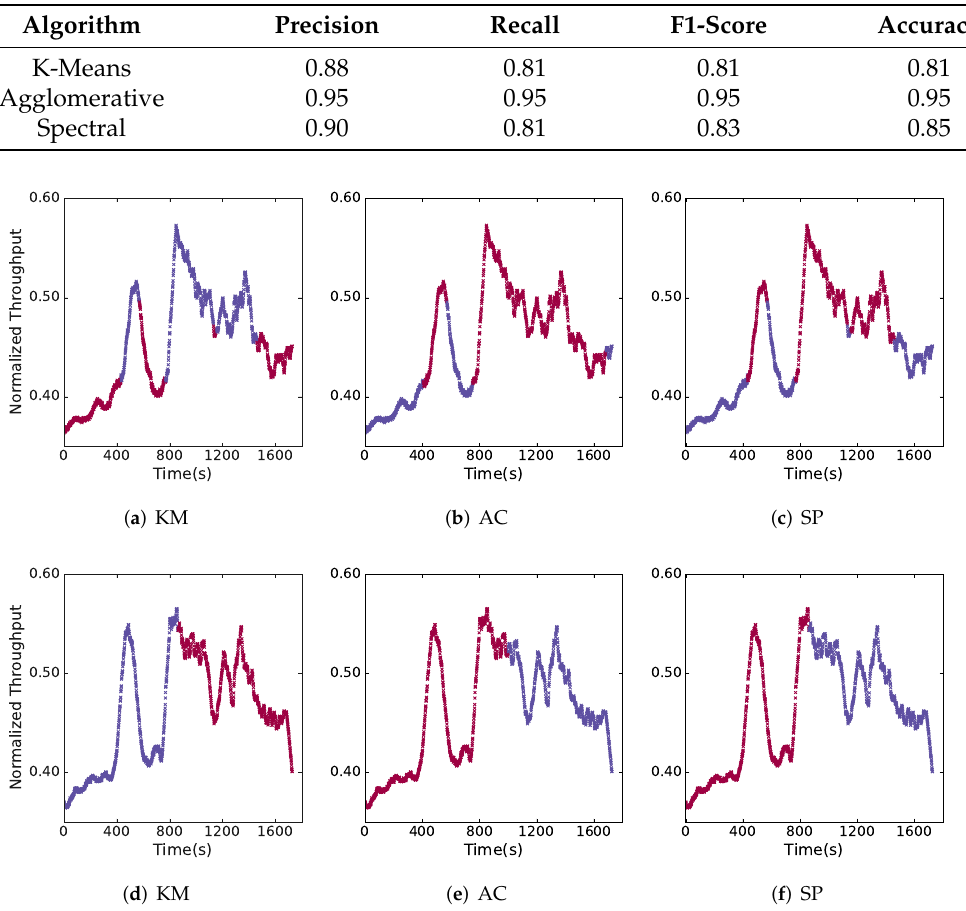
Table 2. The prediction accuracy of the data is labeled by different algorithms.